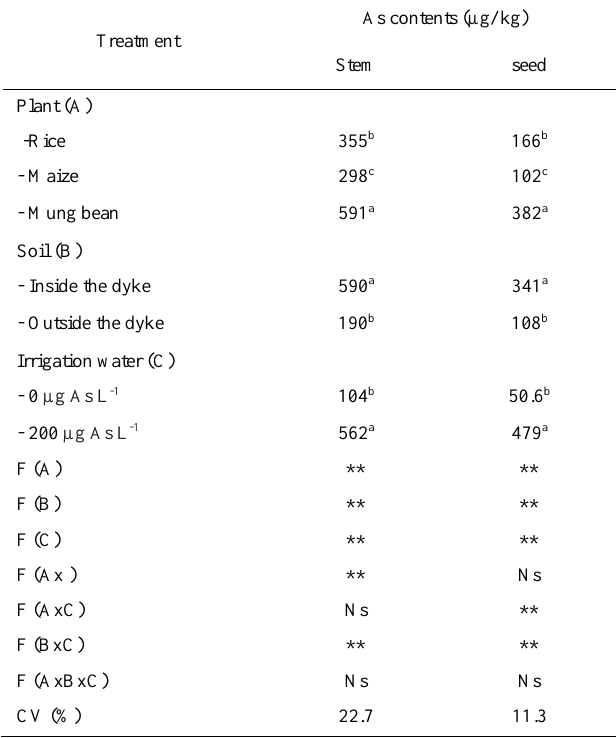
Table 5. Effects of different soils and irrigation water on As contents of rice, maize and mung